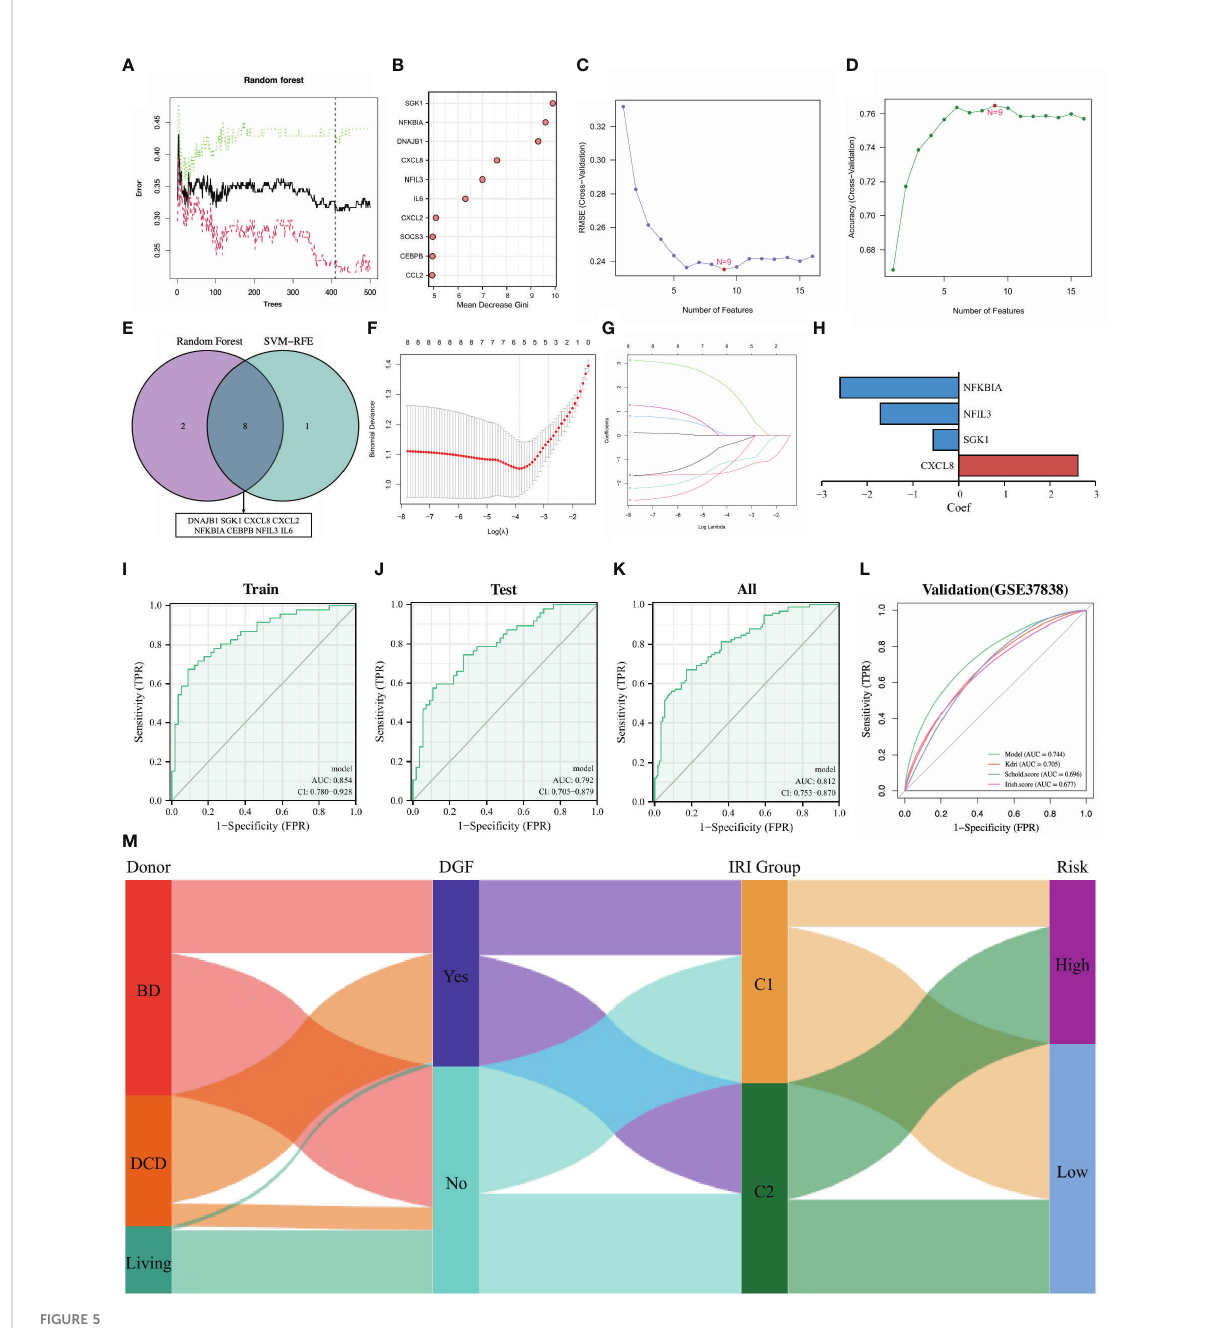
FIGURE 5 Establishment and validation of the DGF predictive model. (A) Random forest tree. The abscissa represents trees and the ordinate represents the error rate. Red represents the DGF samples, green represents the non-DGF samples, and black represents the overall samples. The dotted line represents the tree holding the minimum error rate. (B) : Gini importance measure. The horizontal axis represents mean decrease Gini, and the vertical axis represents characteristic NRGs. (C, D) Feature NRGs were selected with the SVM-RFE algorithm at the optimal point. (E) : Intersecting the top 10 NRGs identi fi ed by the RF and the 9 NRGs screened by the SVM-RFE. (F, G) : The 4 candidate NRGs obtained by LASSO regression with 10-fold cross-validation. (H) : LASSO coef fi cients pro fi les of candidate NRGs in the model. (I – L) : Evaluating the performance of the model in the training set, internal testing set, whole set and external validation set using ROC curves. (M) : Sankey diagram showing the relationships among the type of donors, the occurrence of DGF, the IRI cluster and the risk of IRI samples. DGF, delayed graft function; NRGs, NET-related genes; SVM-RFE, support vector machine recursive feature elimination; RF, random forest; LASSO, least absolute shrinkage and selection operator; ROC, receiver operating characteristic; IRI, ischemia reperfusion